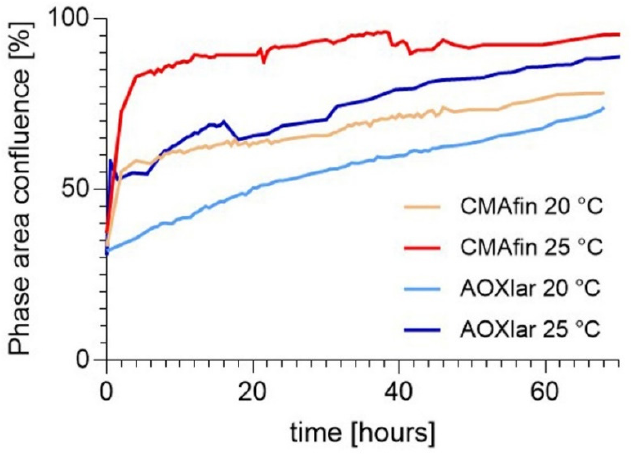
Figure 2. Proliferation of cells cultivated with different temperatures (20 and 25 °C). Growth rates were measured using an Incucyte ® real-time video imaging system (Sartorius AG). Blueish curves are cells of the Atlantic sturgeon (AOXlar7y), and reddish lines are cells from maraena whitefish (CMAfin1).